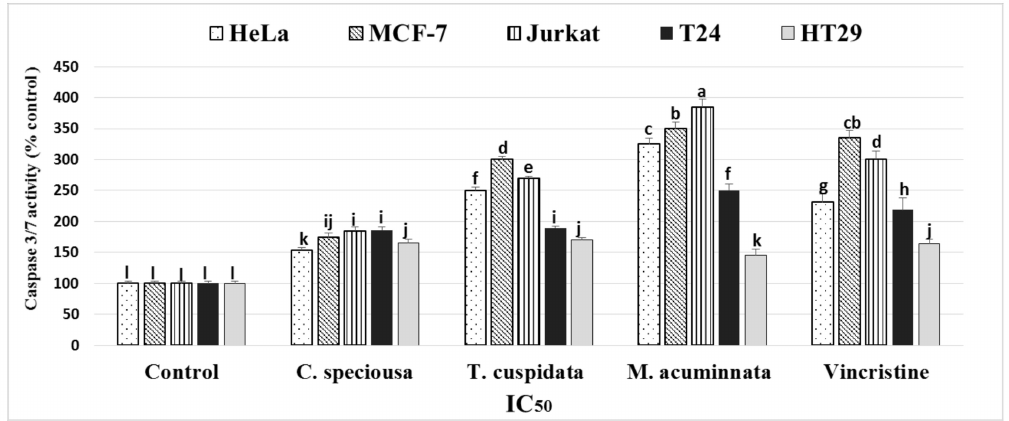
Figure 3. Enzyme activity of caspase 3/7 following treatment of different cancer cells with C. speciousa , T. cuspidate , and M. acuminnata bark extracts (IC 50 ). The activity was expressed as a percentage (%) of untreated